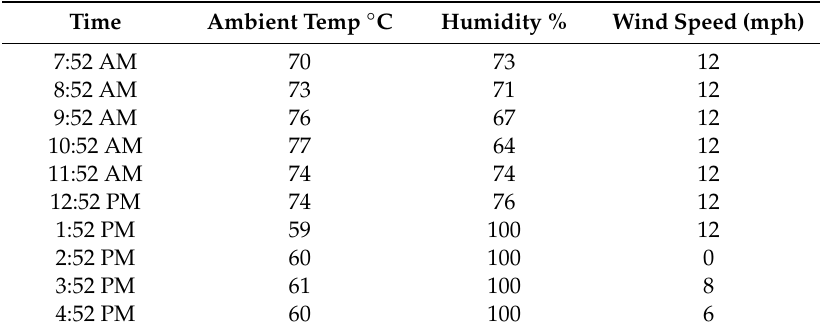
Table 2. Environmental conditions (National Oceanic and Atmospheric Administration (NOAA), Carbondale, IL) during study period in April